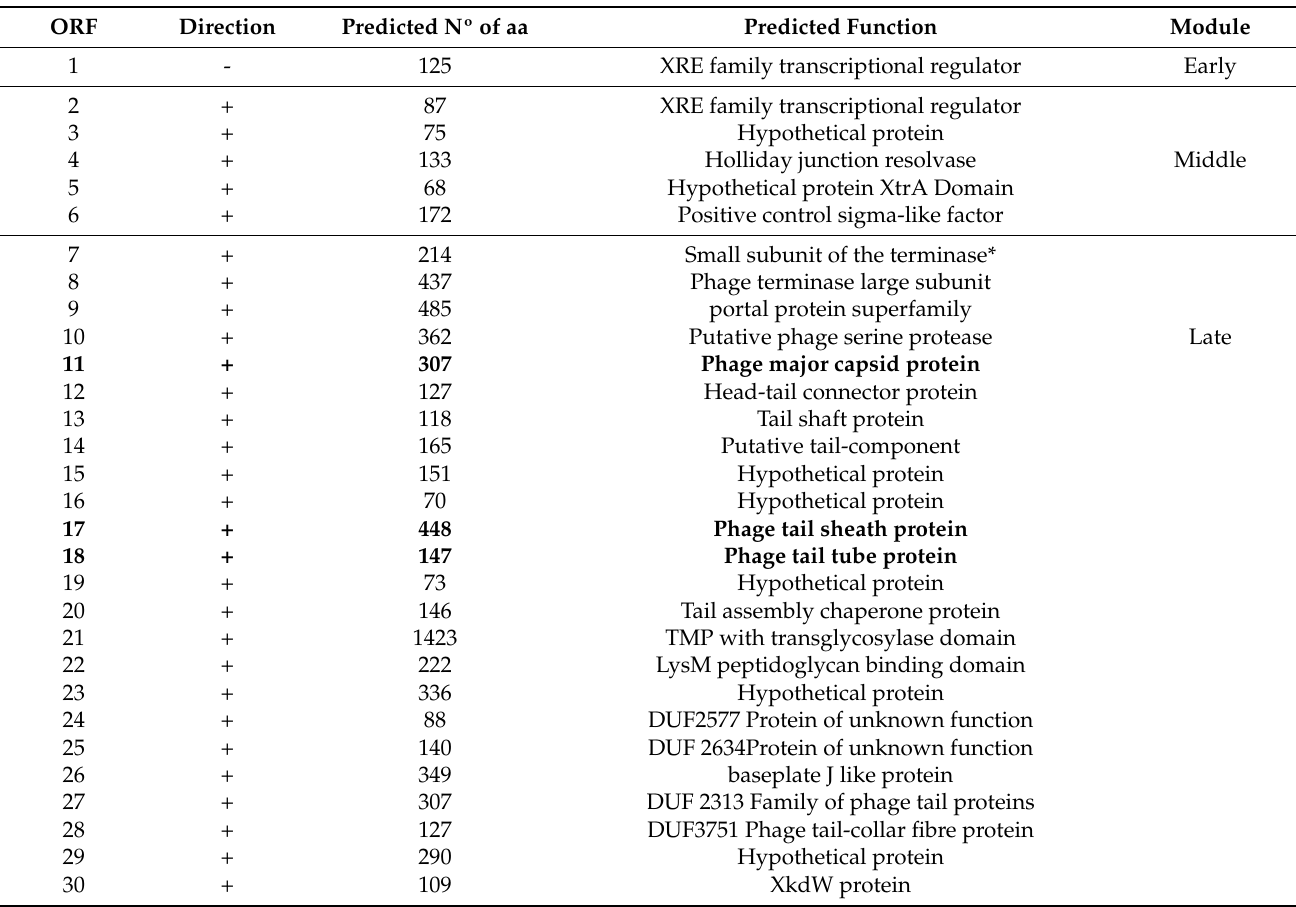
Table 1. Predicted ORFs in the 28.7 Kb region identified by